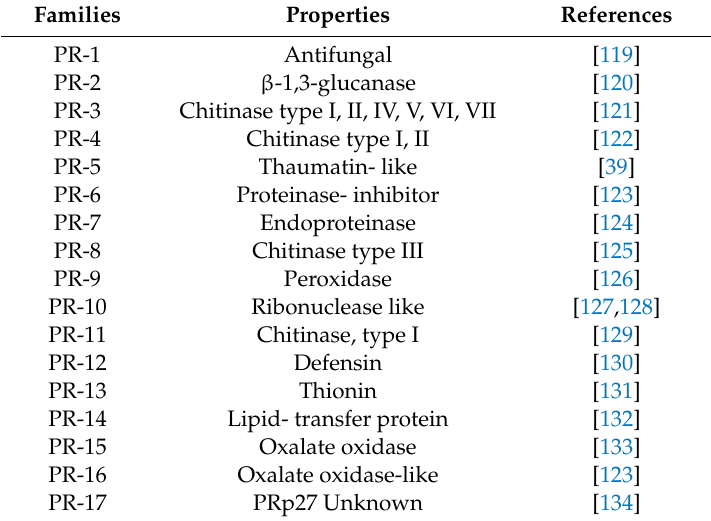
Table 3. Classification of pathogenesis-related proteins and